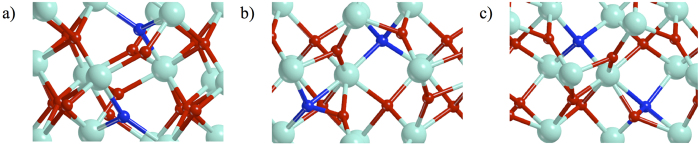
Optimized structures of the most stable magnetic configurations for each 2N-ZrO2 model.(a) 2Nsub3c-ZrO2 FM; (b) Nsub3c/Nsub4c-ZrO2
1CT and (c) 2Nsub4c-ZrO2
1CT.